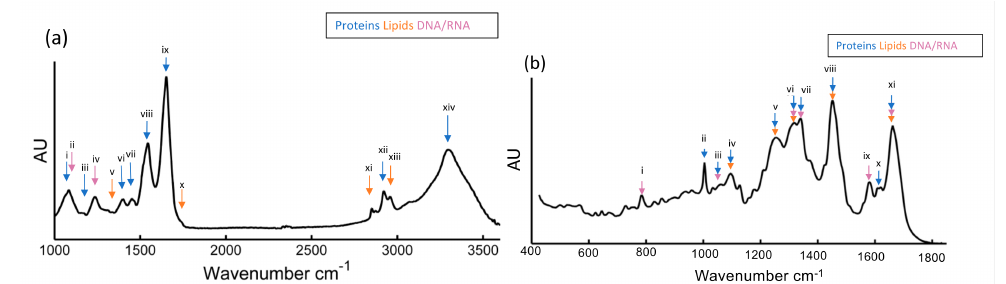
Figure 3. ( a ) Representative mean FTIR spectra recorded for mesenchymal stem cells (bm-MSCs) with classification of relevant peaks and their known association to proteins, nucleic acid, and lipids are described in Table 1A, ( b ) Processed mean Raman spectra for bm-MSCs and their known association to proteins, nucleic acid, and lipids are described in Table 1B